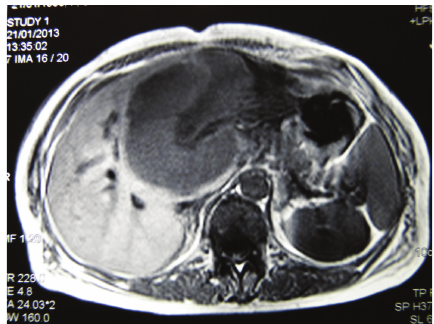
Figure 1: Axial T1-weighted MRI, showing a hypoattenuating hepatic lesion.